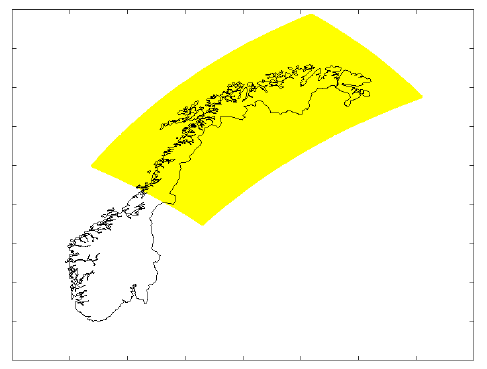
Figure 2. Coverage area used for comparing MEPS and Arome Arctic